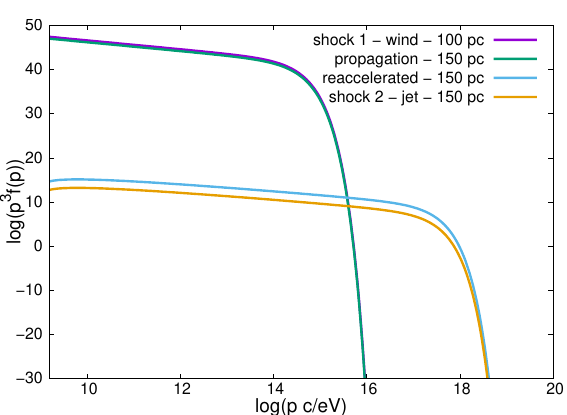
Figure 7. Evolution of the particle distribution between two shocks. Protons are injected at the shock into the wind at z = 100 pc, propagate up to the next shock located at z = 150 pc, where they are reaccelerated.